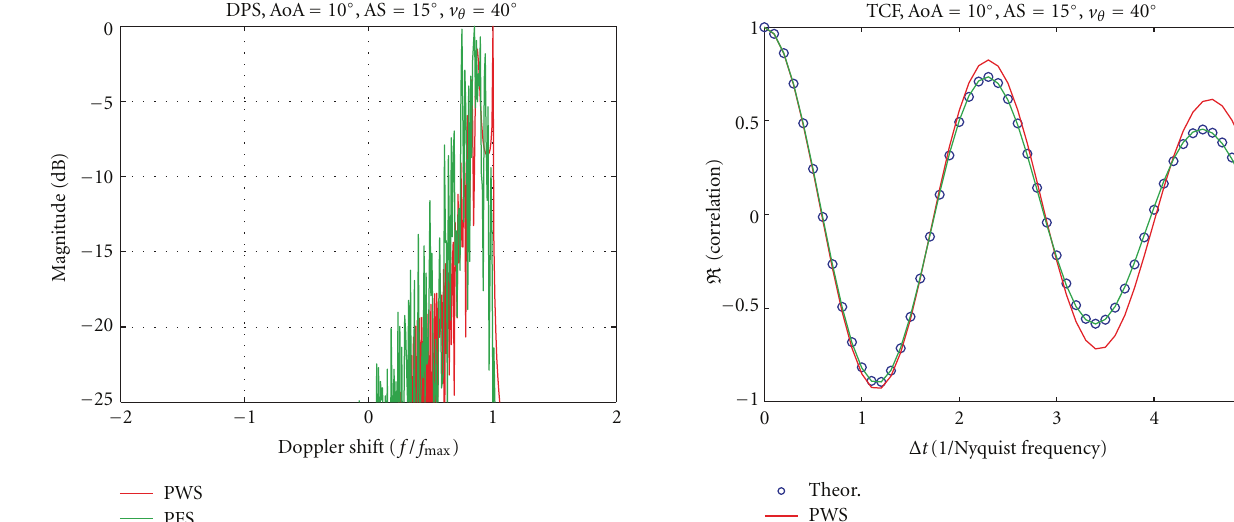
DPS, AoA = 10 ◦ , AS = 15 ◦ ,